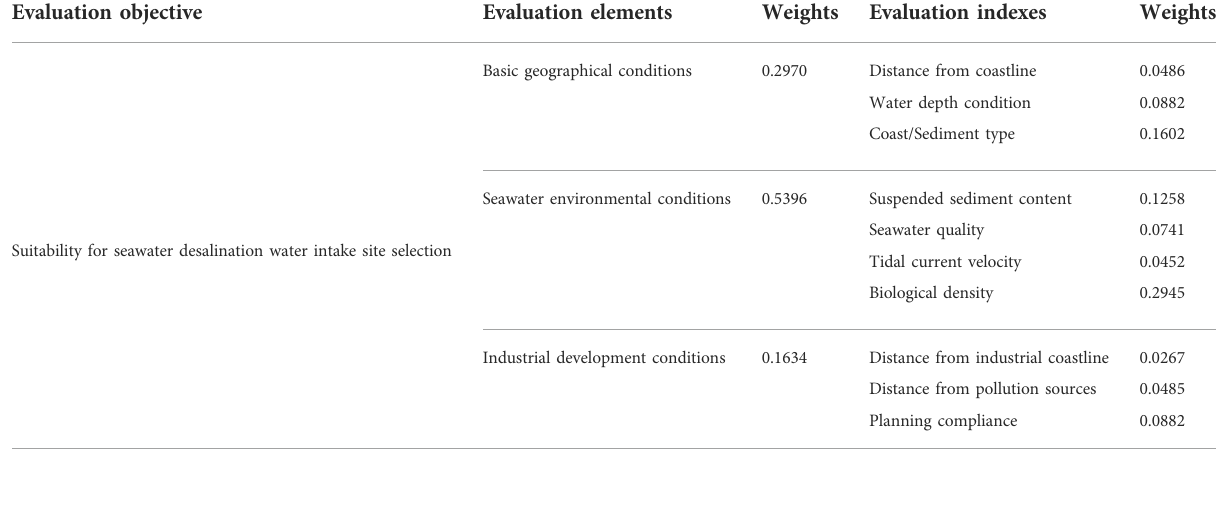
TABLE 9 Weight calculation results for the evaluation indexes.